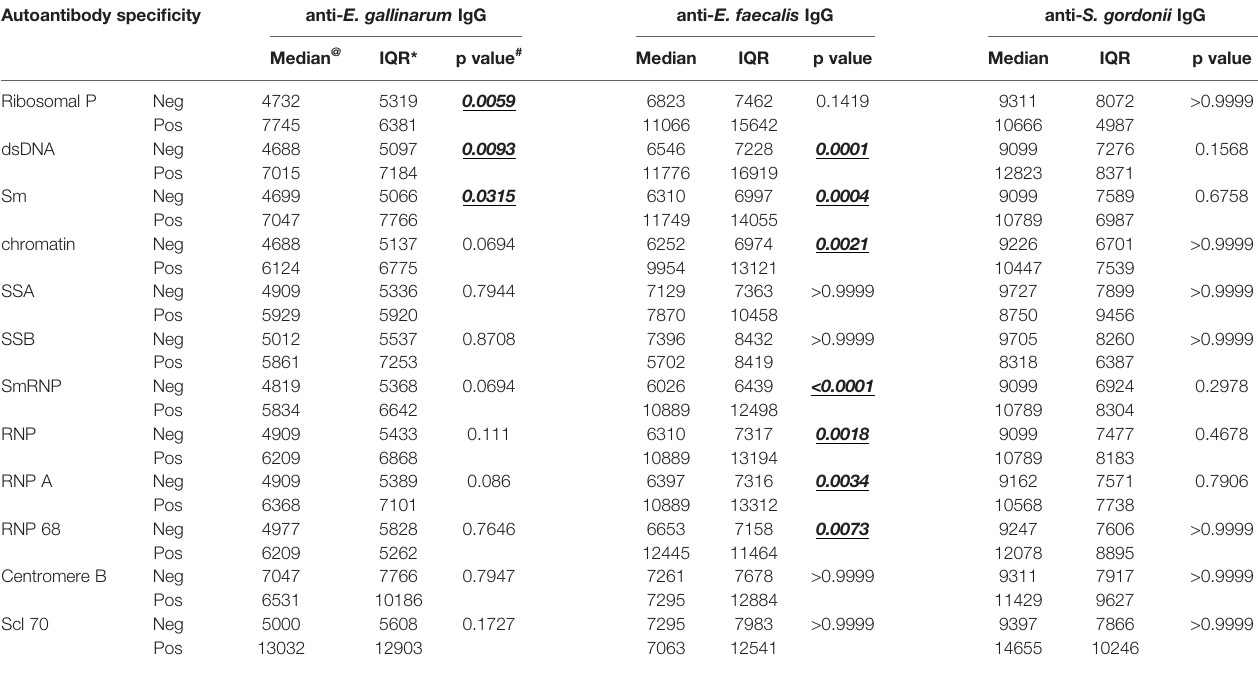
TABLE 1 | Association between lupus autoantibodies and anti-bacterial IgG titers in SLE patients. Autoantibody speci fi city